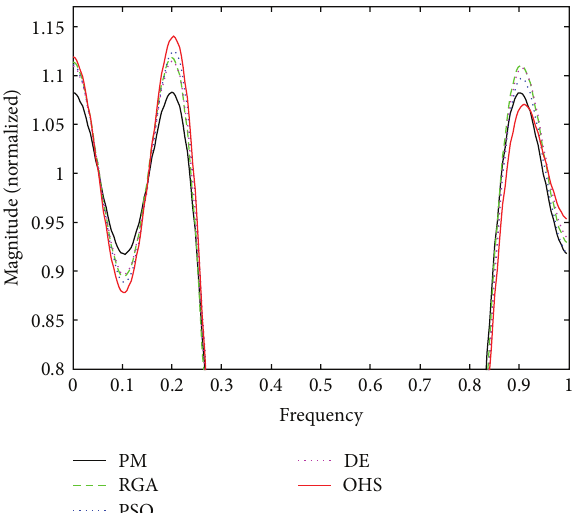
Figure 15: Normalized pass band ripple plot for the FIR BS filter of order 20.